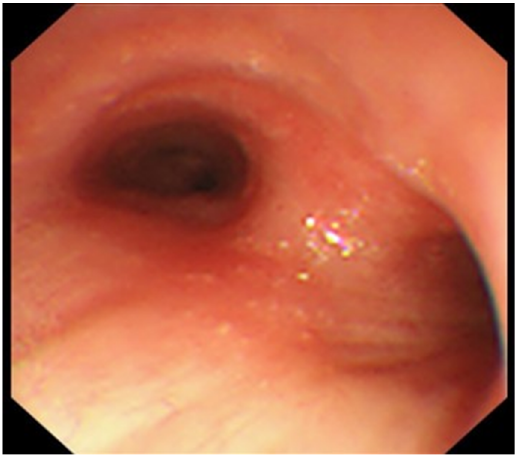
Figure 3. The bronchoscopy image shows a dull formation of the carina.